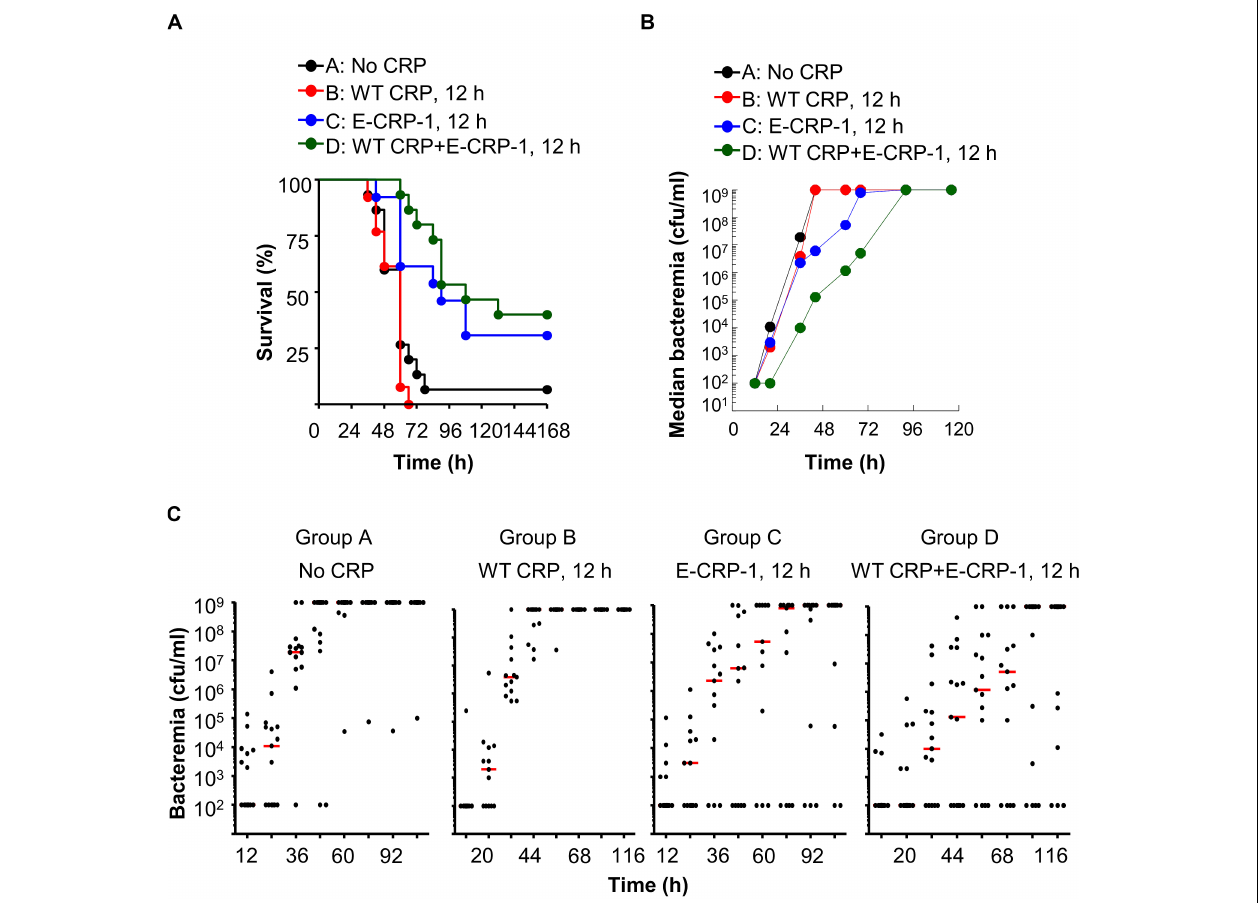
FIGURE 7 | Unlike WT CRP, E-CRP-1 is protective against late-stage infection. The data are combined from two separate experiments with six to eight mice in each group in each experiment. (A) Survival curves. Pneumococci were injected first; CRP was injected 12 h later. The p -values for the differences in the survival curves between groups A B, A C, A D, B C, B D and C D were 0.28, < 0.01, < 0.001, < 0.001, < 0.001 and 0.31, respectively. (B) Bacteremia. Blood was collected from each surviving mouse shown in A . The median bacteremia values are plotted. The p -values for the differences between groups A B and C D were > 0.05 at all time points. For 44–92 h, the p -values for the differences between groups B C and B D were < 0.01. (C) Scatter plots of the bacteremia data shown in B . The horizontal line in each group of mice represents median